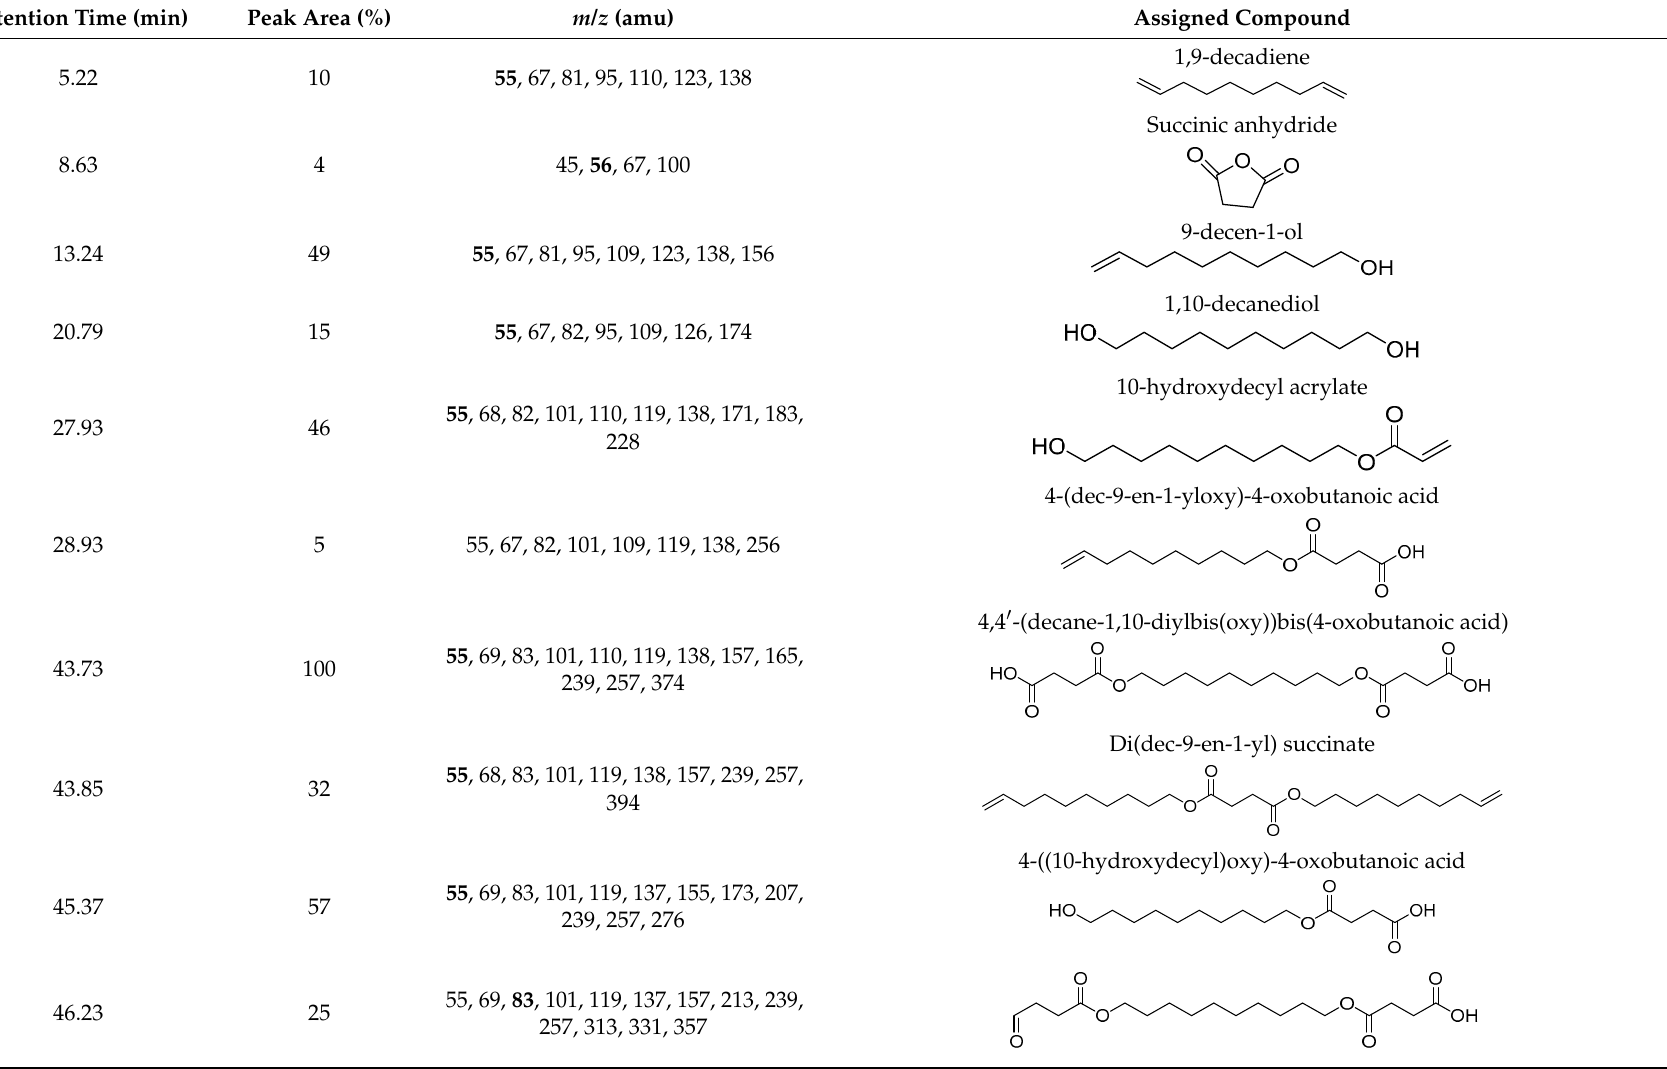
m/z Figure 7. Mass spectra of the major decomposition products of PDeSu.